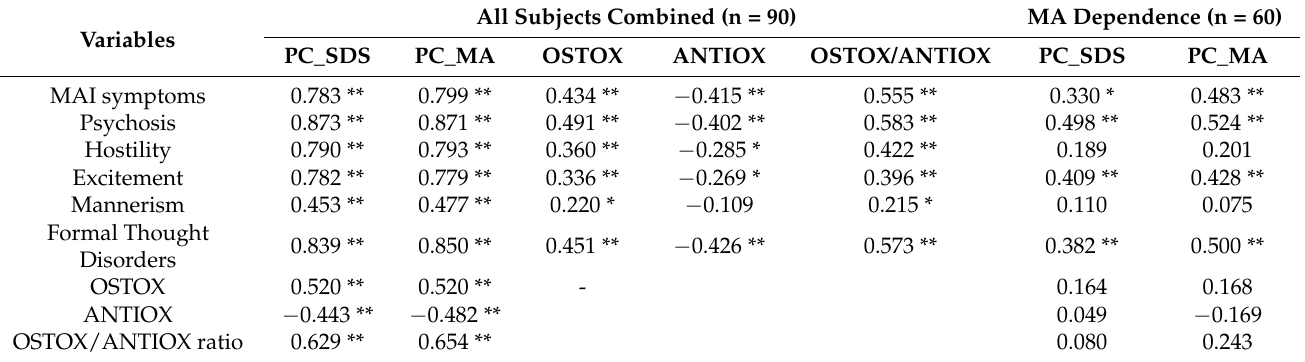
Table 4. Intercorrelations between severity of methamphetamine (MA) dependence (PC_SDS) and severity of MA dependence (PC_MA), methamphetamine abuse (MA), oxidative stress parameters, and symptoms